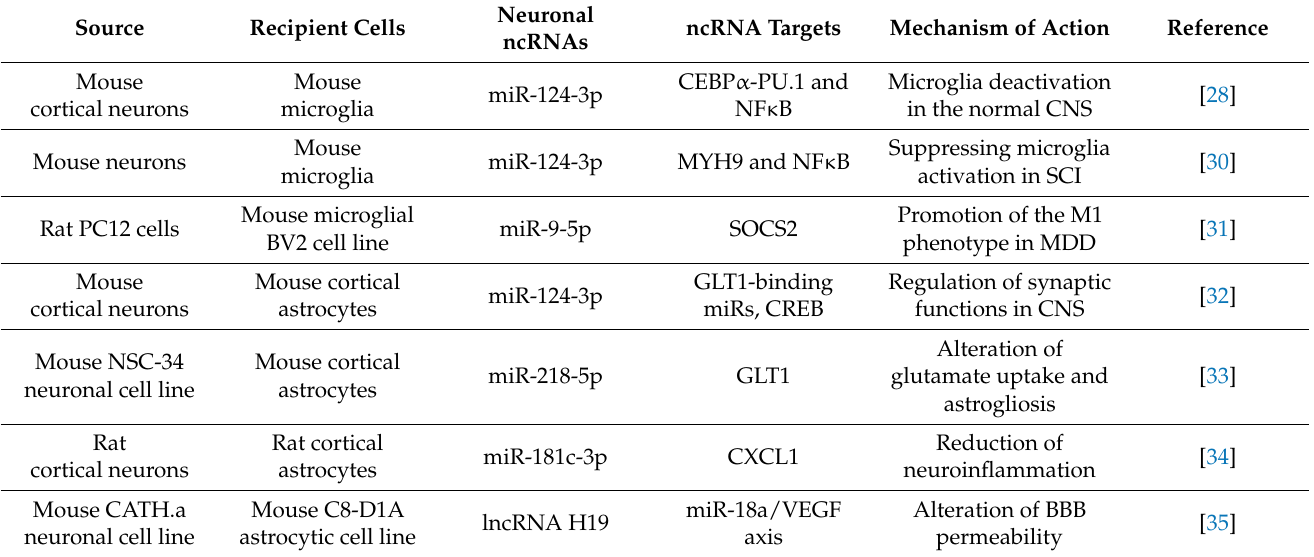
Table 1. Summary of neuronal EV-derived ncRNAs, their targets, and